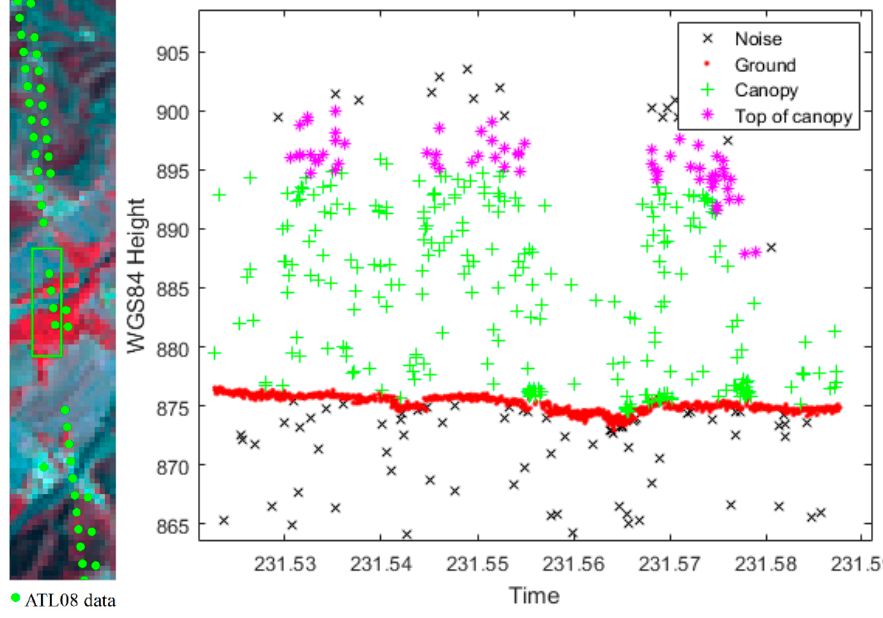
Figure 7. Photon classification map (on the right ) corresponding to atl08 data (on the left ).